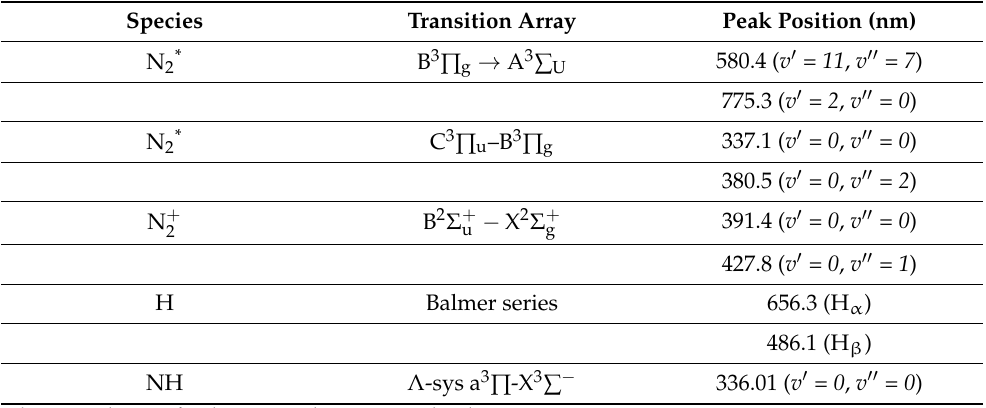
Table 1. Reference data for generated species by N 2 + H 2 plasmas. Species Transition